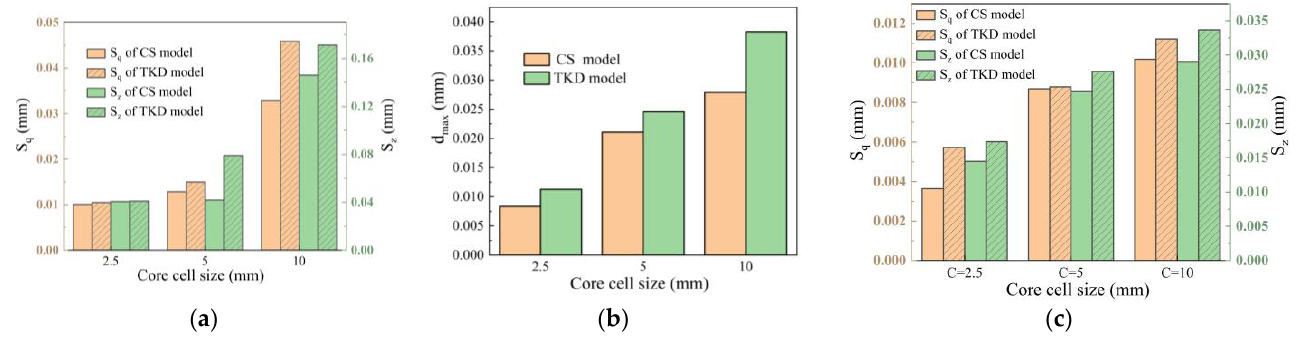
S of spherical AFSP with different core cell sizes ( b ) Figure 15. ( a ) S and Figure 15. ( a ) S q and S z of spherical AFSP with different core cell sizes ( b ) d max of spherical AFSP z q S of saddle-shaped AFSP with different core cell AFSP with different core cell sizes ( c ) S and with different core cell sizes ( c ) S q and S z of saddle-shaped AFSP with different core cell z q sizes.